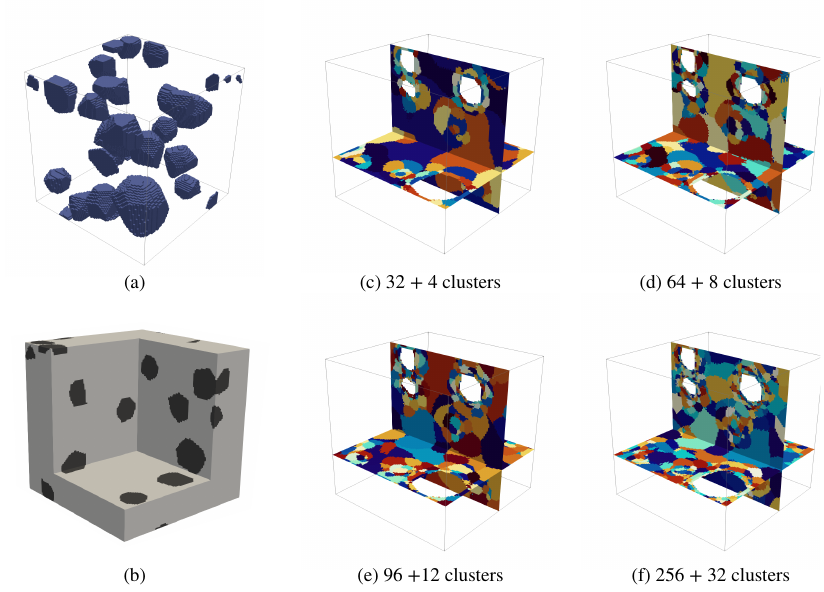
Figure 7. ( a , b ) Idealised concrete mesostructures considered in the second analysis. The numerical sample of size 5.05 cm is discretised by 101 3 voxels. The aggregates are modelled using polyhedrons with an aspect ratio ranging from 1 to 1.5 and an average size of 10–15 mm. The inclusion phase occupies a volume fraction of 9.87%; ( c – f ) reduced microstructures with 36, 72, 108 and 288